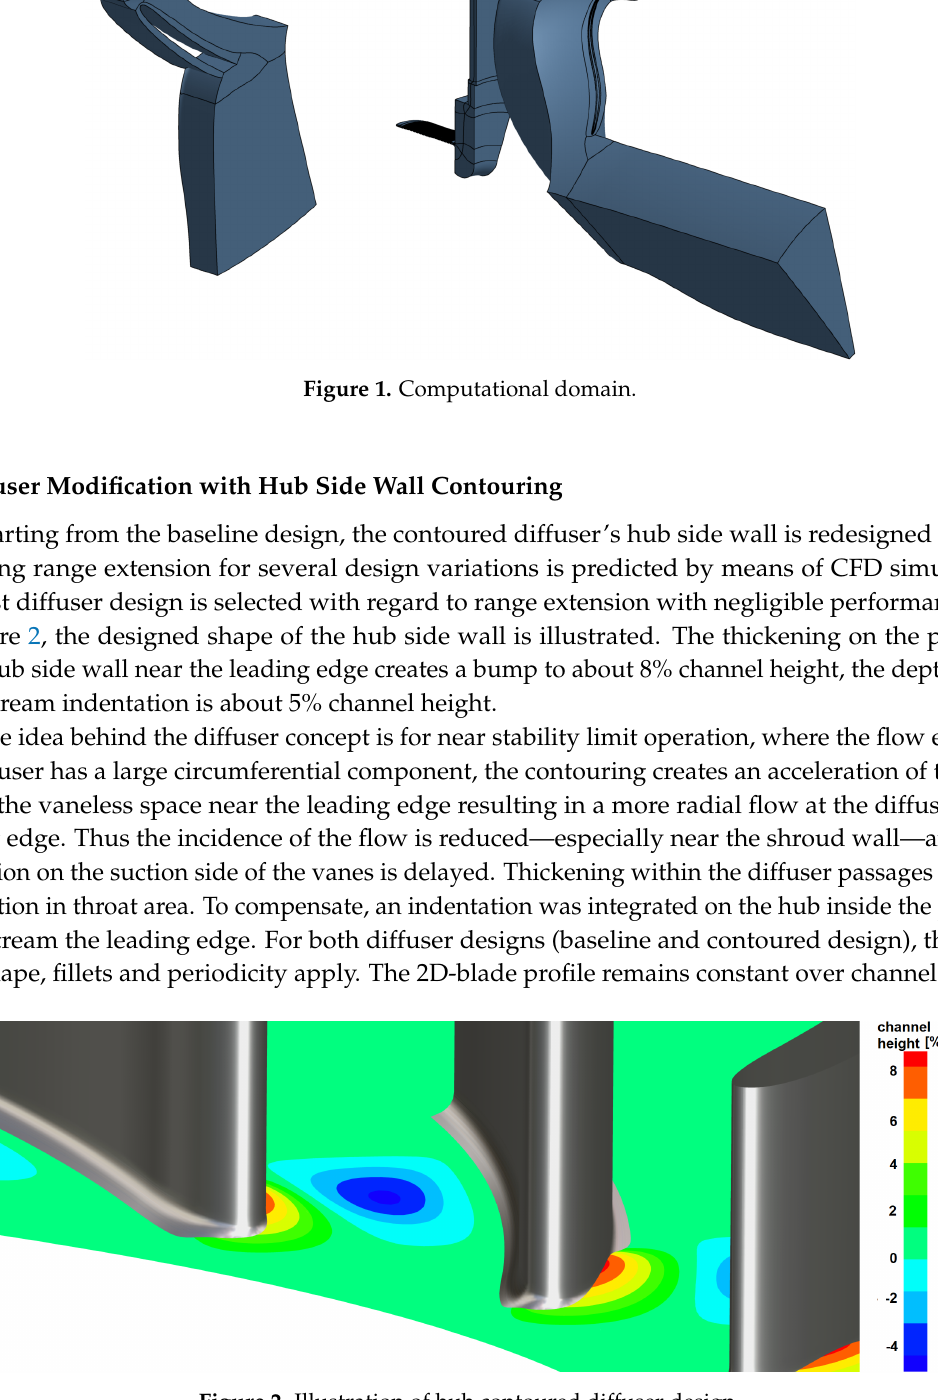
Figure 2. Illustration of hub contoured diffuser